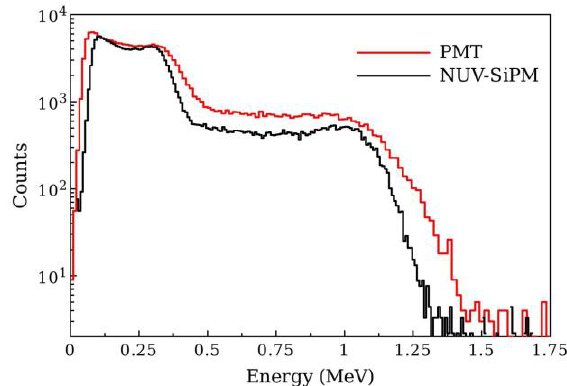
Fig. 5. 22 Na spectra using the PMT and the NUV-SiPM array coupled to the EJ- 299 (20 mm dia. x 20 mm thick.).